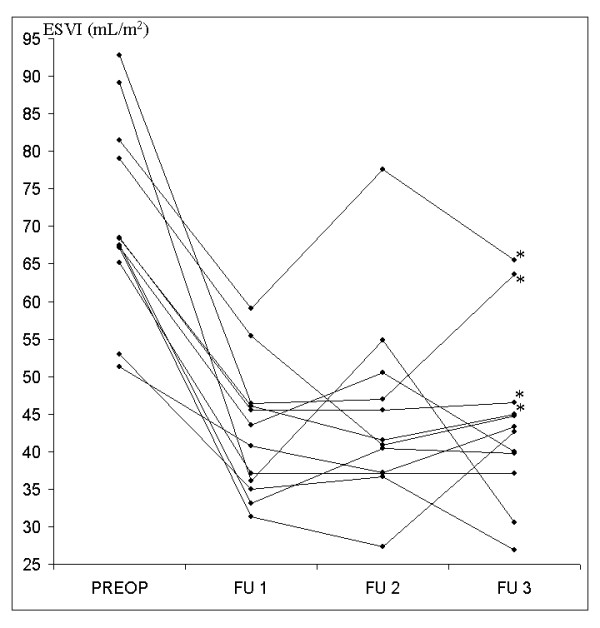
Time-course of end-systolic volume index for each patient. Singles values of ESVI and their modifications during time. Note that preoperative larger ventricles have wider changes during time. '*' Flags grade 2 mitral regurgitation.